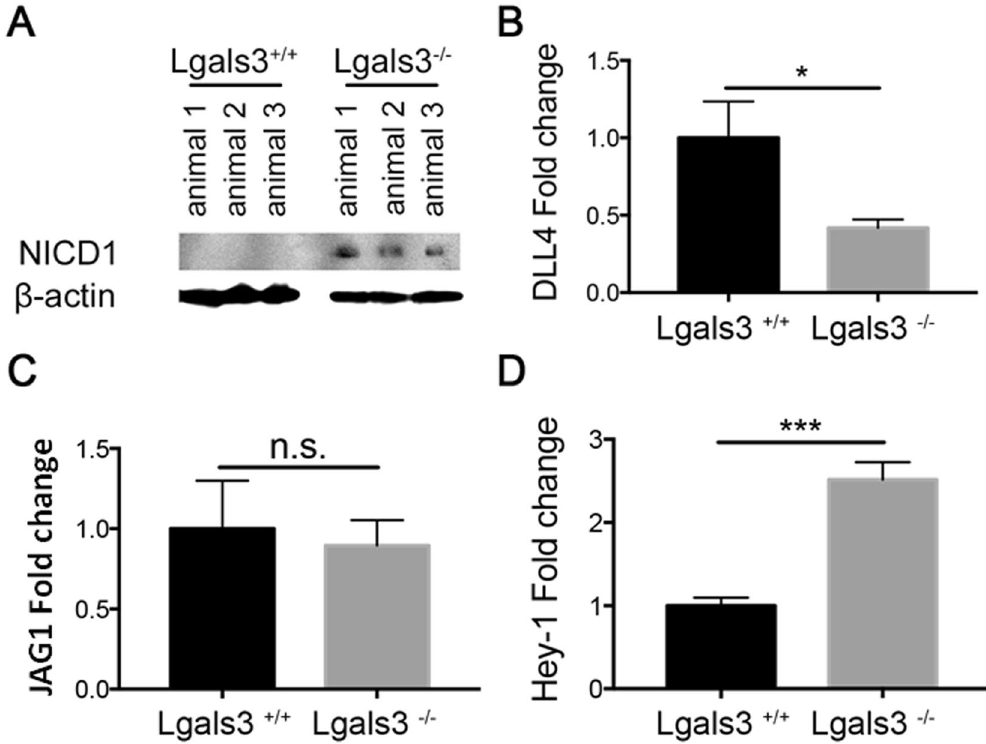
Figure 6. Notch target genes on B220 + cells sorted by FACS. ( A ) Notch-1 intracellular domain (NICD1) was significantly cleavage in Lgals3 − / − B220 + cells and DLL4 was more evident in Lgals3 + / + B220 + cells. β -actin was used as endogenous control. ( B ) mRNA levels of DLL4 in B220 + cells of Lgals3 + / + and Lgals3 − / − mice. ( C ) mRNA levels of JAG1 in B220 + cells of both mice groups. ( D ) mRNA levels of Notch target gene Hey-1 in B220 + cells of Lgals3 + / + and Lgals3 − / − mice. n = 5 mice per group. ( * ) Indicates p < 0.05. ( *** ) Indicates p <